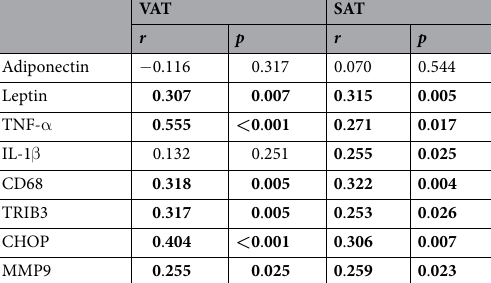
Table 3. Correlations between the mRNA expression of ANGPTL2 and that of other genes in the adipose tissue depots of study participants. n = 77, r = Pearson correlation